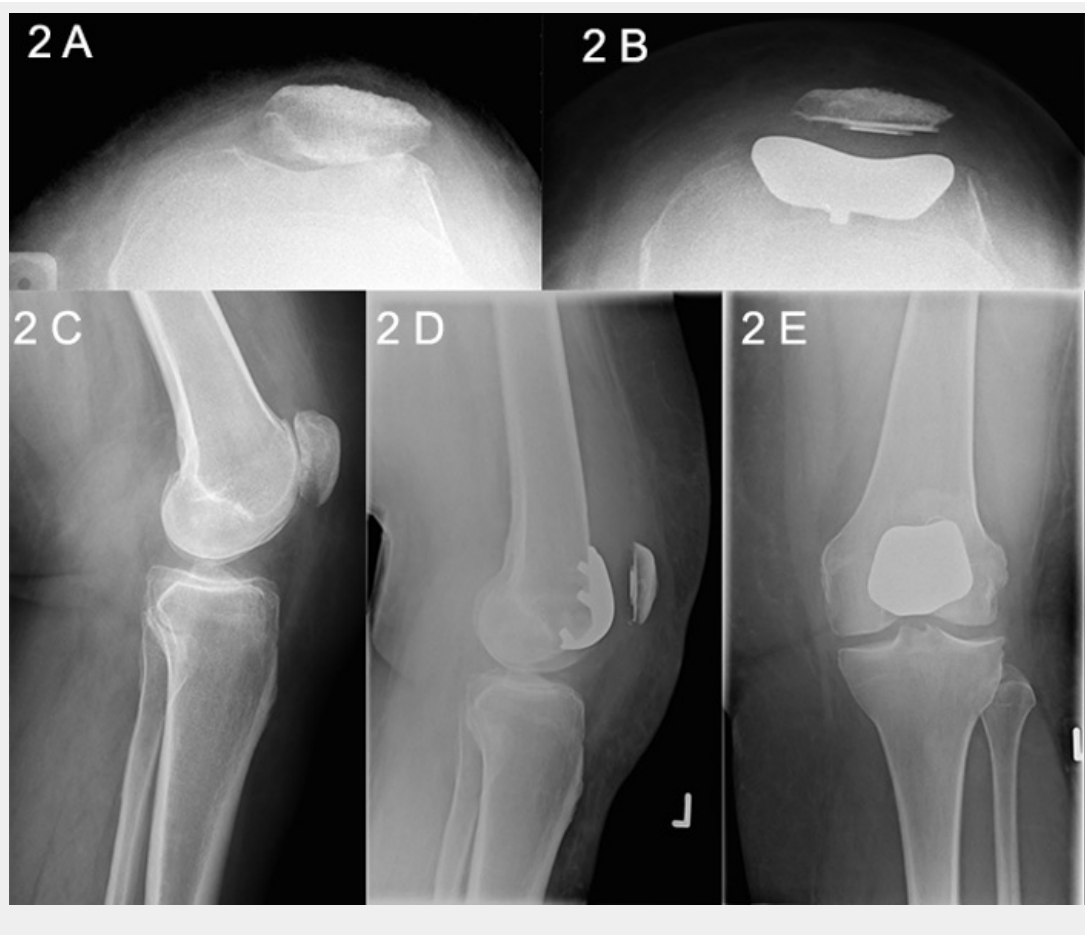
Figure 2 Patellofemoral joint (PFJ) arthritis. A. Skyline X-Ray showing PFJ osteoarthritis. B. Skyline X-ray after PFJ replacement. C. Lateral X-ray showing PFJ osteoarthritis. D. Postoperative lateral X-ray after PFJ arthroplasty. E. Anteroposterior X-ray after PFJ